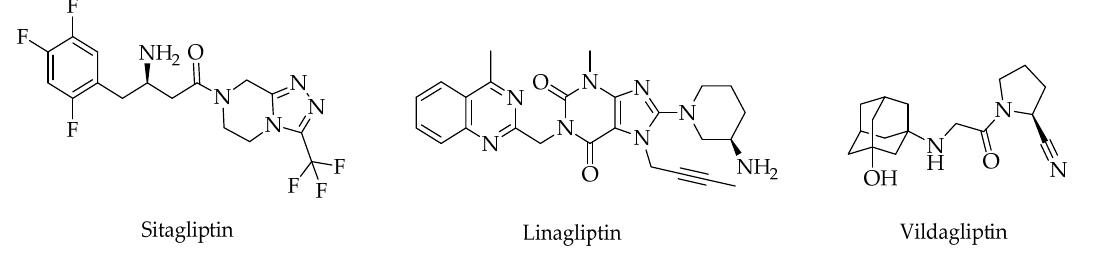
Figure 1. Some DPP-4 inhibitors.